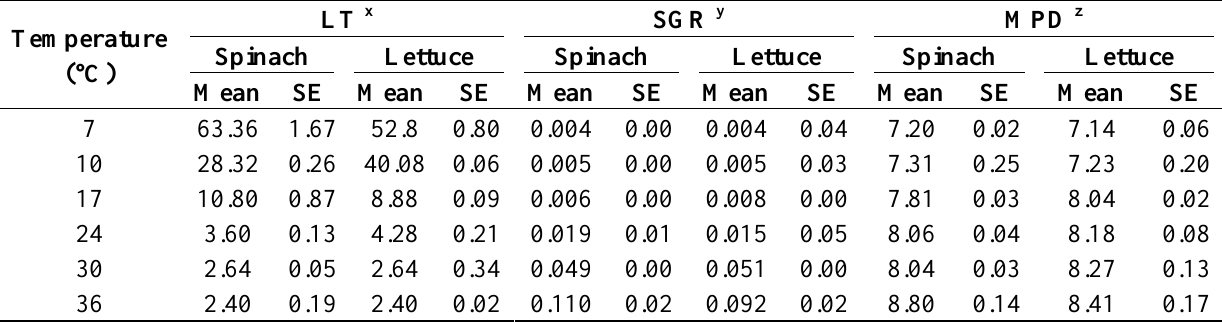
Table 1. Growth kinetics of primary models for a mixture of E. coli O157:H7 NR in blanched spinach and fresh-cut iceberg lettuce.